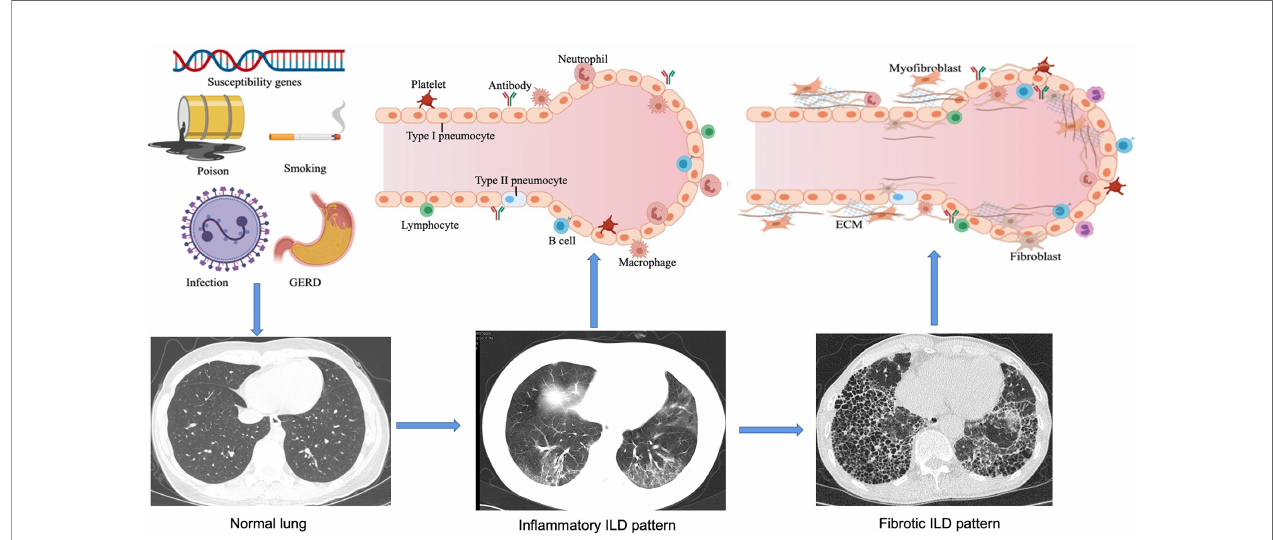
FIGURE 1 | Pathogenesis and development of ILD. In genetically susceptible individuals, external factors such as smoking, environmental chemicals, infections and gastroesophageal re fl ux disease (GERD) can lead to epithelial cell injury and aberrant repair, alveolar macrophage activation, neutrophil recruitment, and oxidative stress. Over time, increased ECM turnover will result in the development of fi brosis. With these exposures the host's immune tolerance is broken leading to chronic in fl ammation from cellular and humoral autoimmunity, endothelial cell dysfunction, granuloma formation, and alveolar macrophage activation thus further aggravating in fl ammation. As the disease progresses, interstitial pneumonia changes from an early alveolitis (increased alveolar space content of in fl ammatory products, re fl ecting in fl ammatory ILD pattern) to a transition period (thickened alveolar septum and the deposition of collagen fi bers, signi fi cantly reduced capillary beds), and eventually ending in alveolar structural destruction and fi brosis. This fi gure is created with